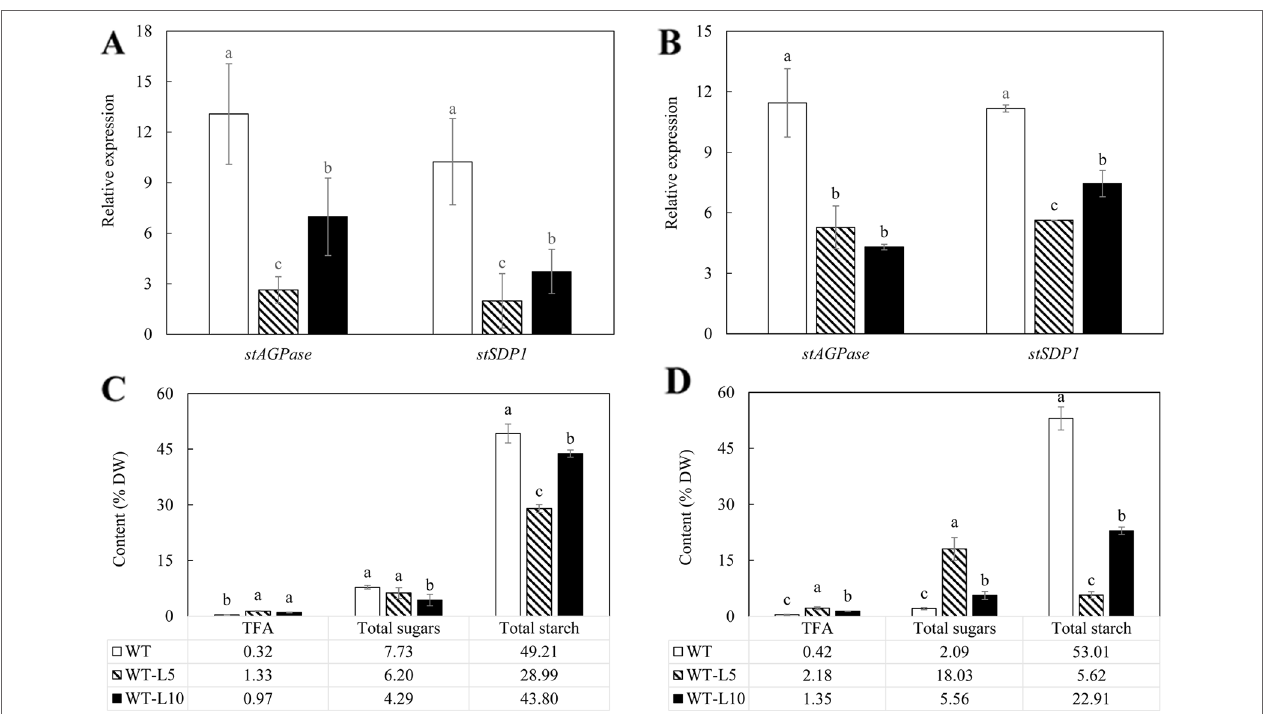
FigURE 2 | Gene expression analysis and total carbon allocation in the potato tubers of WT (open bars) and the two selected WT-derived lines, WT-L5 (hatched bars) and WT-L10 (black bars) at two developmental stages. (A) Real-time quantitative reverse transcription polymerase chain reaction (qRT-PCR) result at the flowering stage; (B) Real-time qRT-PCR result at the mature stage; (c) Total carbon allocation at the flowering stage; (D) Total carbon allocation at the mature stage. The data represent the mean values ± SD of three biological replicates. Letters (a, b, c) above the bars are based on LSD, bars marked with different letters are statistically significantly different at P <